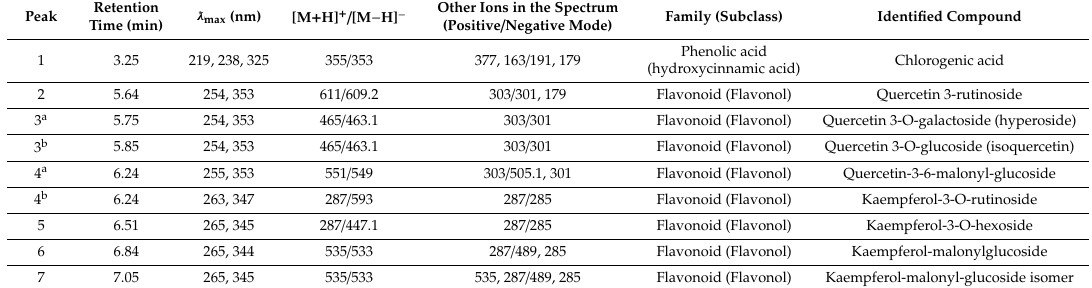
Figure 4. UHPLC profiles of CA extracts issued from infusion Bodum ® extraction mode for ‘fine’ ground CA material monitored at 273 nm. Typical UV spectra of main compounds are given on the right. UV spectrum of Chlorogenic acid (1) represents hydrocinnamic acid derivatives (12, 13, 15), UV spectrum of Isookanin-7-O-glucoside (9) represents Eriodicyol-7-O-glucoside (8 a ), UV spectrum of Luteolin-7-O-glucuronide (11) represents 6,8-C,C-diglucosyl-apigenin (8 b ) and Apigenin-7-glucuronide (14). See Table 5 for peak ID. Lot number: 559980. See Figure S5 for UHPLC profiles of other lots. Table 4. Putative peak identification of the major compounds detected by UHPLC-DAD in the BC extracts. λ max are the local maximum of absorbance on the UV spectrum. [M + H] − and [M − H] − columns provide the m / z value of the precursor ion. Other ions column gives the m / z value of the Table 5. Putatively peak identification of the major compounds detected by UHPLC-DAD in the CA fragments that were detected in the MS spectra. Identification method using UV and ESI( + ) and ESI( − ) extracts. λ max are the local maximum of absorbance on the UV spectrum. [M − H] − column provides the m/z value of the precursor ion. Other ions column gives the m/z value of the fragments that were spectra. Lot number: 55870. detected in the MS spectra. Identification method using UV and ESI (-) spectra. Lot number: 559980.